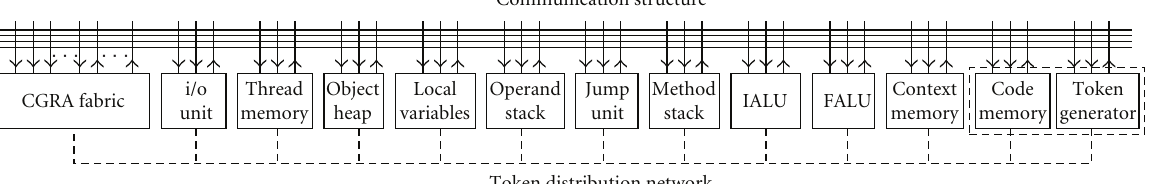
Figure 2: Model of a Java (non)Virtual Machine on AMIDAR basis.